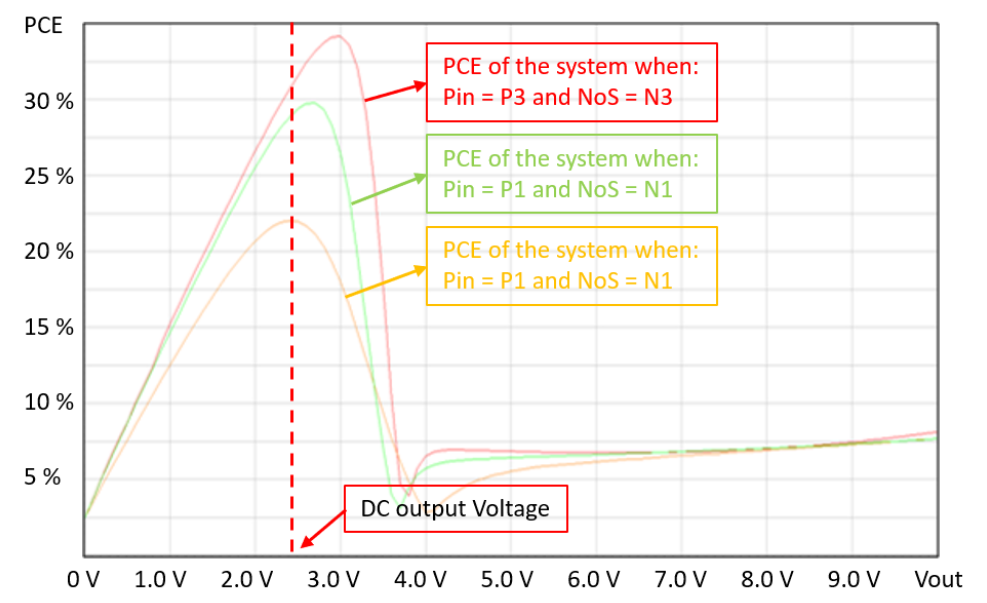
Figure 6. PCE vs. DC output voltage of a dynamic RF to DC